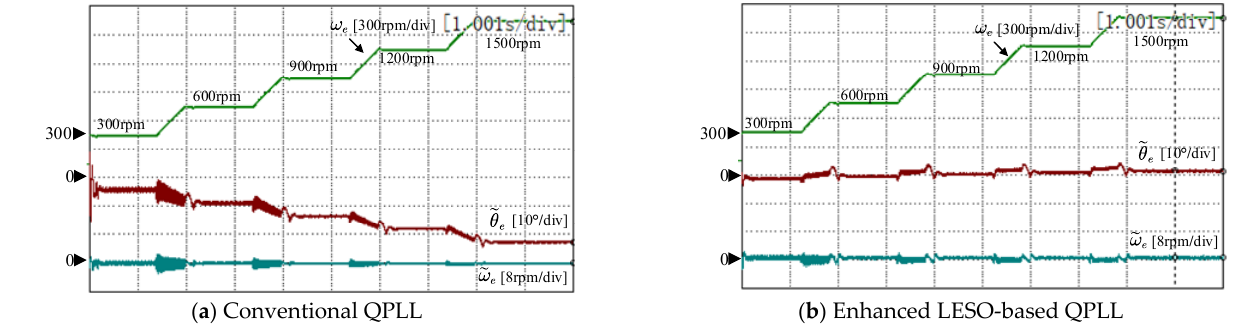
Figure 14. Experimental results of the real speed, the position estimation error, and the speed estimation error at different operating speeds under no load.